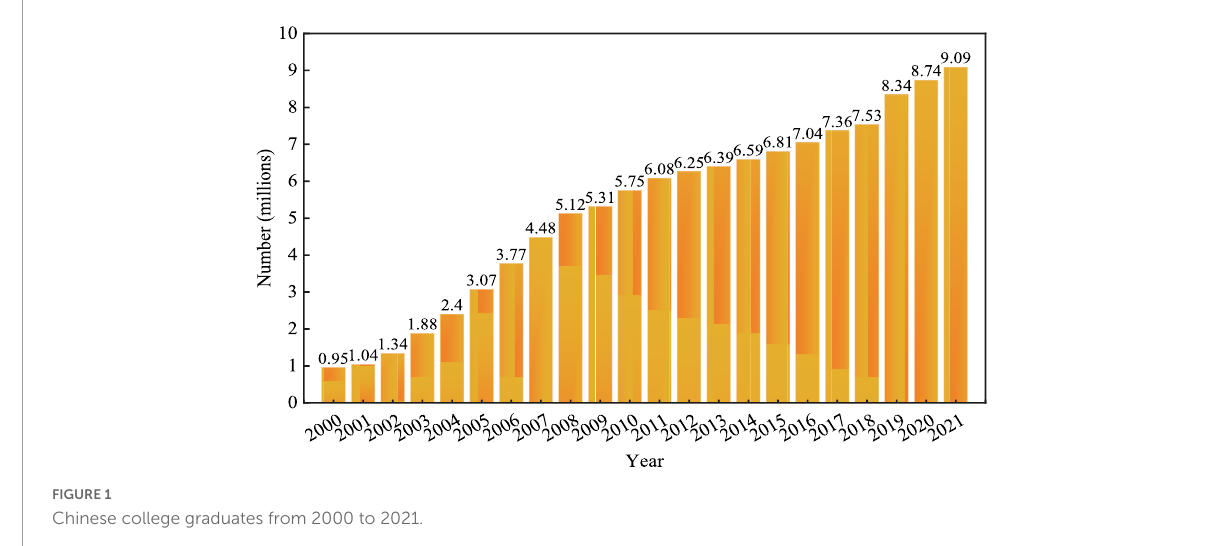
FIGURE1 Chinese college graduates from 2000 to